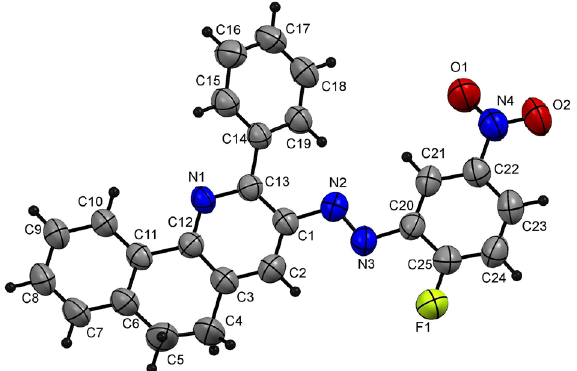
Figure 5. X-ray plot of single crystallographic data collected for 6b . Mercury (version 3.8) (https ://www.ccdc. cam.ac.uk/solut ions/csd-syste m/compo nents /mercu ry/) was used to create this figure.